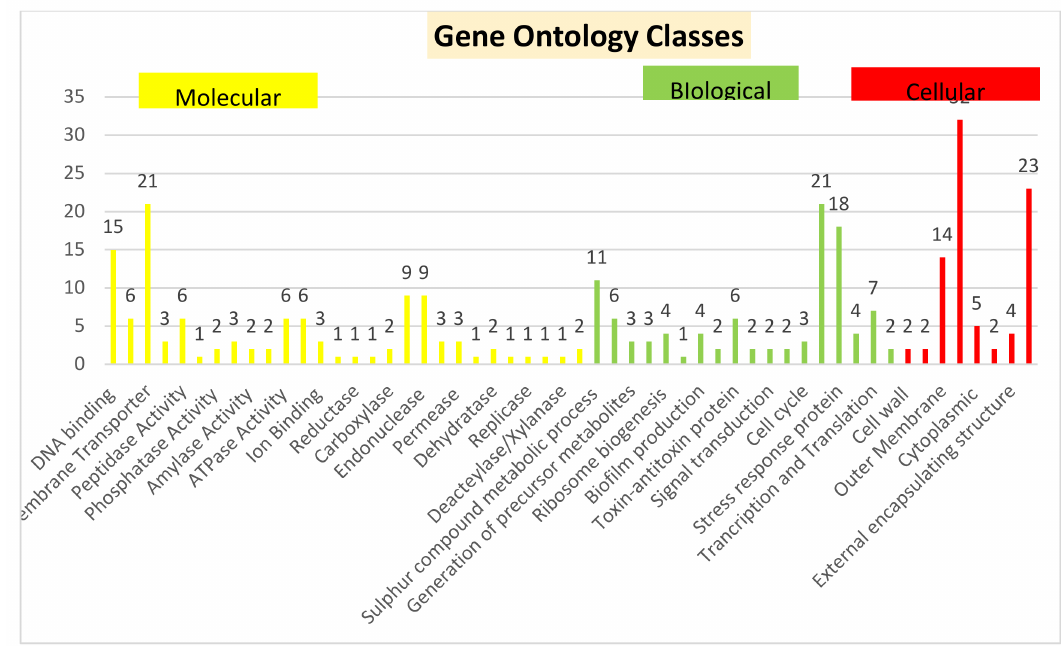
Figure 5. Gene ontology of 246 hypothetical proteins in S. flexneri strain 1c. The proteins were classified according to biological, cellular and molecular functions based on the domain analysis done with Cello2Go, UniProt and InterProScan (Some functions fall in more than one gene ontology